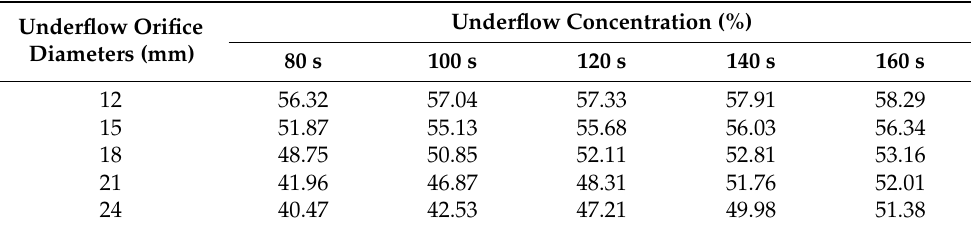
Table 7. Changes in the underflow concentration under different underflow orifice diameters.